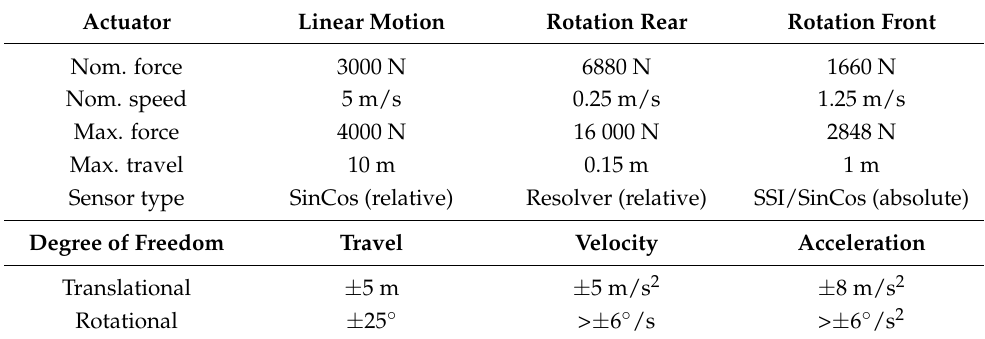
Table 1. Specifications of the longitudinal driving simulator “Driveception” at IMS [6] (pp. 56–78).